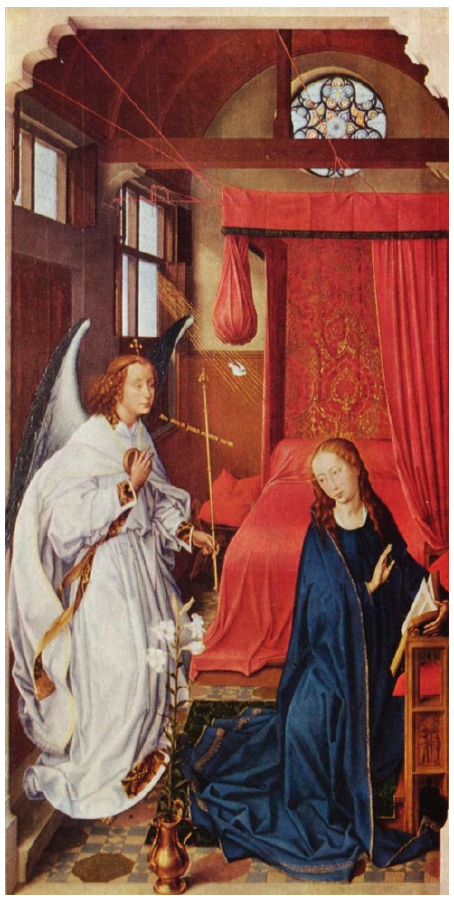
Figure 10. Rogier van der Weyden, The Annunciation , left wing of The St. Columba Altarpiece , c. 1455, Alte Pinakothek, Munich.